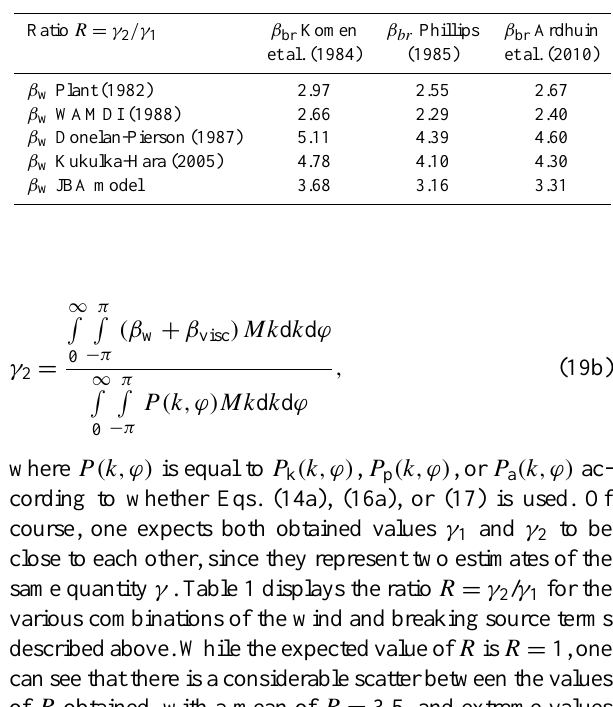
Table 1. Ratio R = γ 2 /γ 1 , where γ 1 and γ 2 are the coefficients of the wave breaking dissipation term required to fulfill the energy and momentum balance, respectively, for different combinations of the expressions of β w and β br assumed. The sea wave spectral model for k < 25 k p is from Elfouhaily et al. (1997), with directional spreading function by Resio et al. (2011). Above k = 25 k p , the sea wave directional spectral model is from Elfouhaily et al. (1997). A wind speed U = 10ms − 1 is assumed.